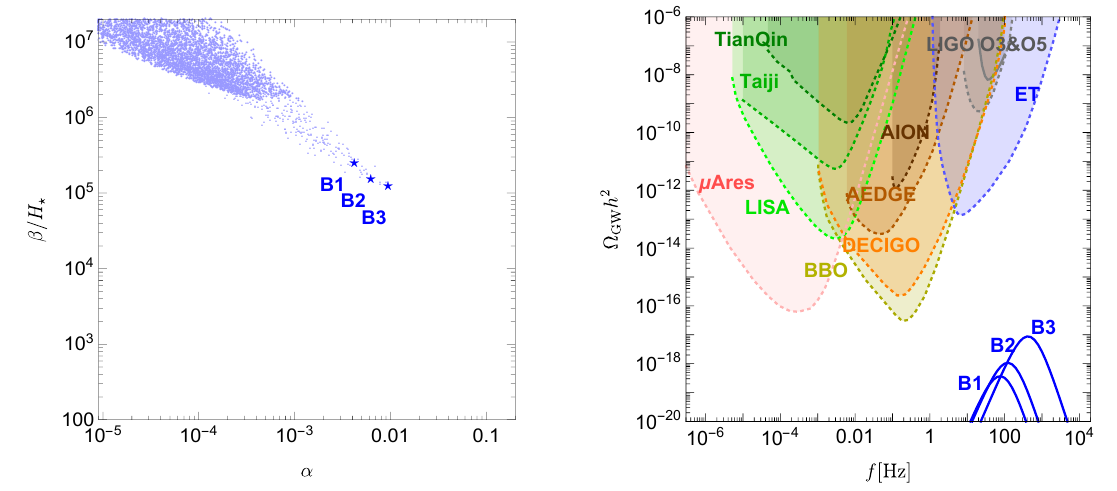
Figure 3 . Potential with logarithmic field dependence and no cubic term at zero temperature. Left panel: scatter plot in the ( α, β/H ) plane. Right panel: GW spectra for the three benchmark ? points in table 2 and marked with stars in the left